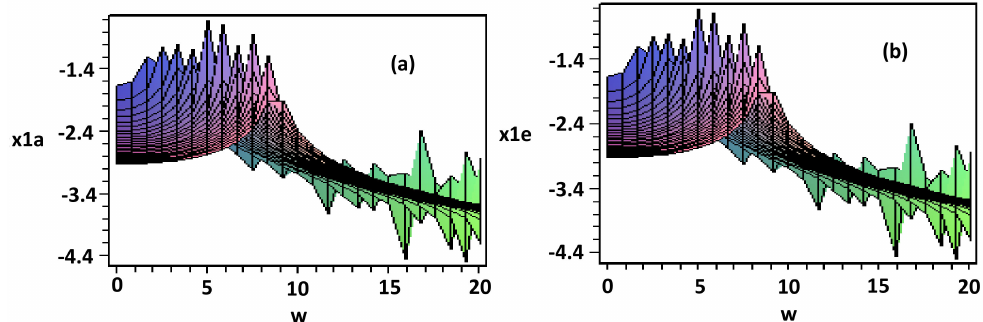
Figure 13. Evolution of x 1 (w) as a function of P 1 : ( a ): Present approach. ( b ): Exact solution. The evolution of the displacement x 2 (in the circular natural frequency space) as a (exact